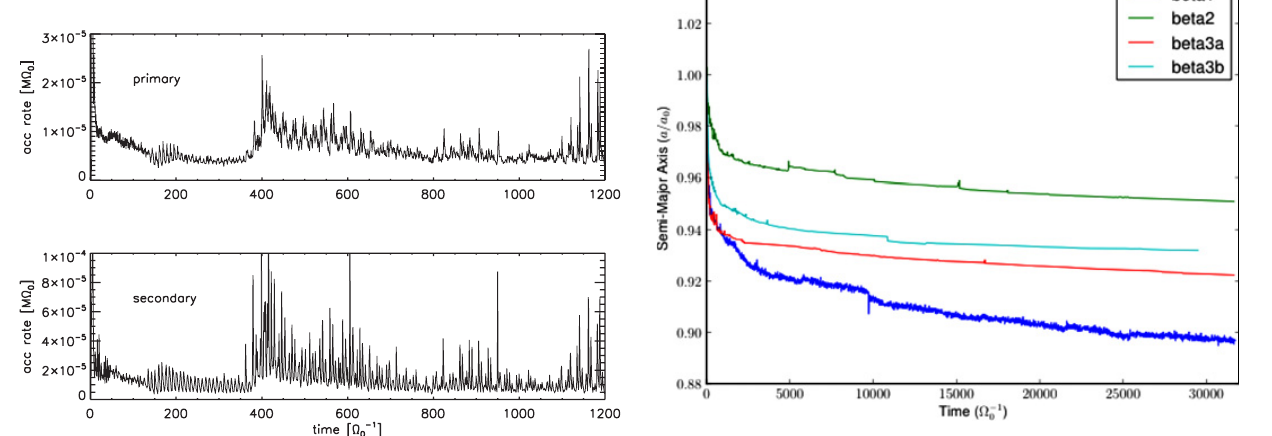
Figure 4. Accretion rate onto each black hole as a function of time. Notice the variability and the fact that the accretion rate is higher for the secondary. Figures from Cuadra et al (2009).